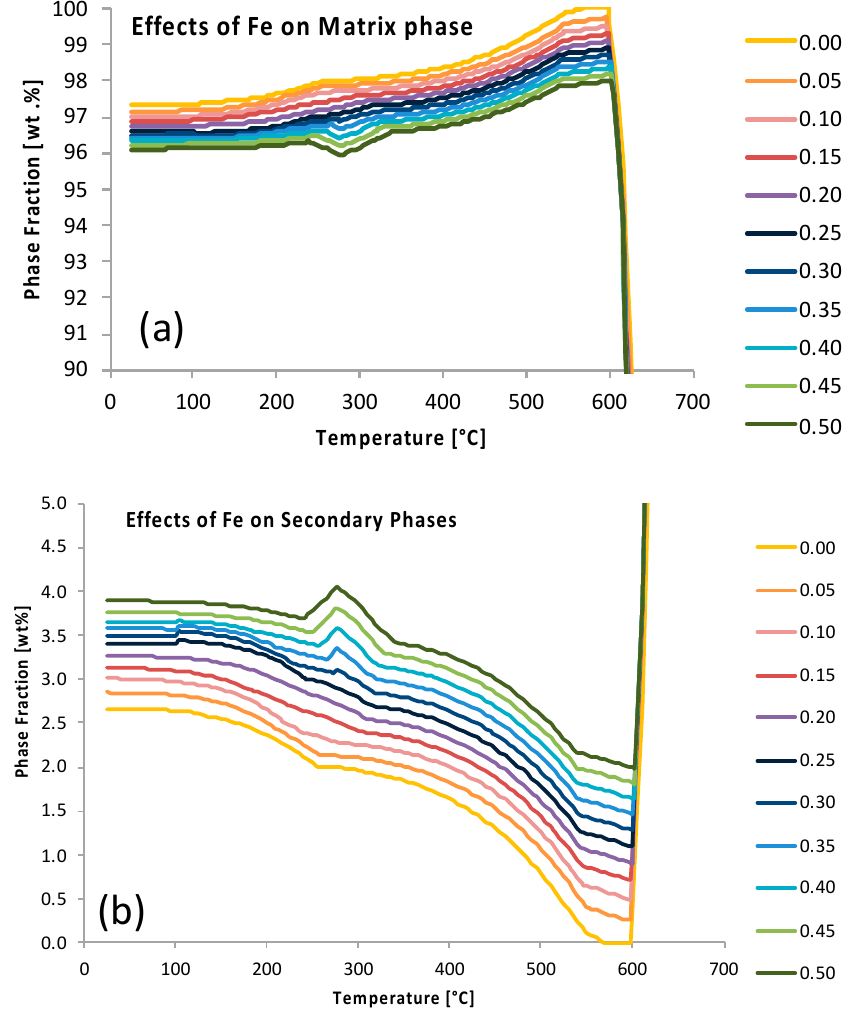
Figure 12. Data associated with the ψ s for iron on the matrix phase present in Al 6061 at 25 ◦ C are presented in ( a ). Data associated with the ψ s for iron for the summation of the secondary phases present in Al 6061 at 25 ◦ C are presented in ( b ).